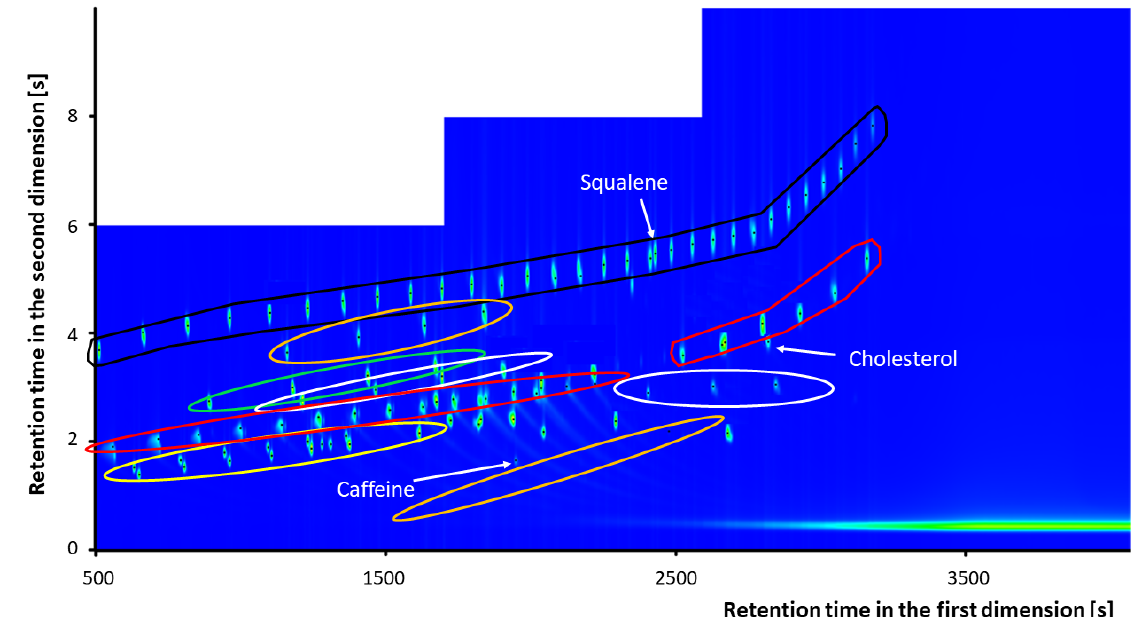
Figure 8. The TIC 2D chromatogram of the model mixture (composition see Table 1) measured under the conditions described in Section 2.4 on Rxi-200 MS (2 + 30 m) and TG-5HT (1 m) columns. The marked classification zones are the following: black ( n -alkanes), lower dark yellow (amines), upper dark yellow (amides), green (chloroalkanes), left white (alcohols), right white (ethers), yellow (aldehydes and ketones), left red (acids and esters), right red (esters of higher fatty acids), and unlabeled (others).